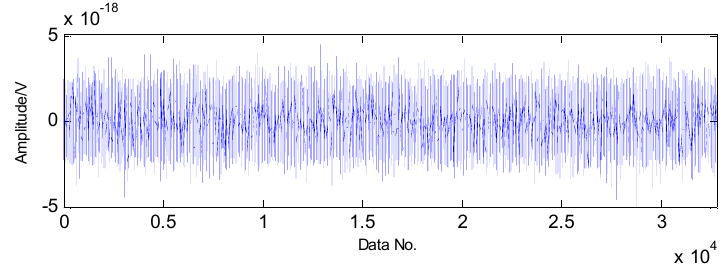
Figure 29. The transient impact component using TQWT.